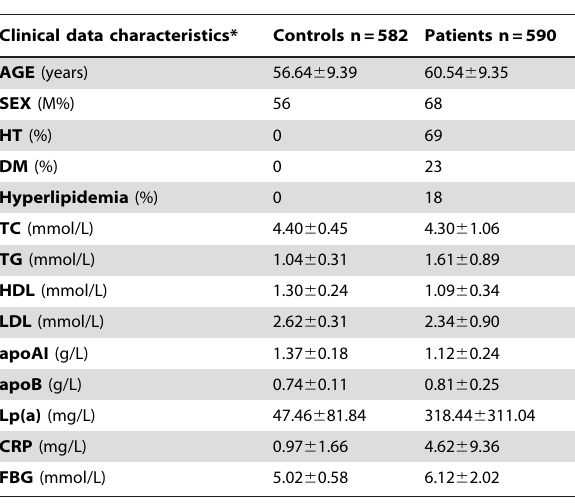
Clinical data characteristics*